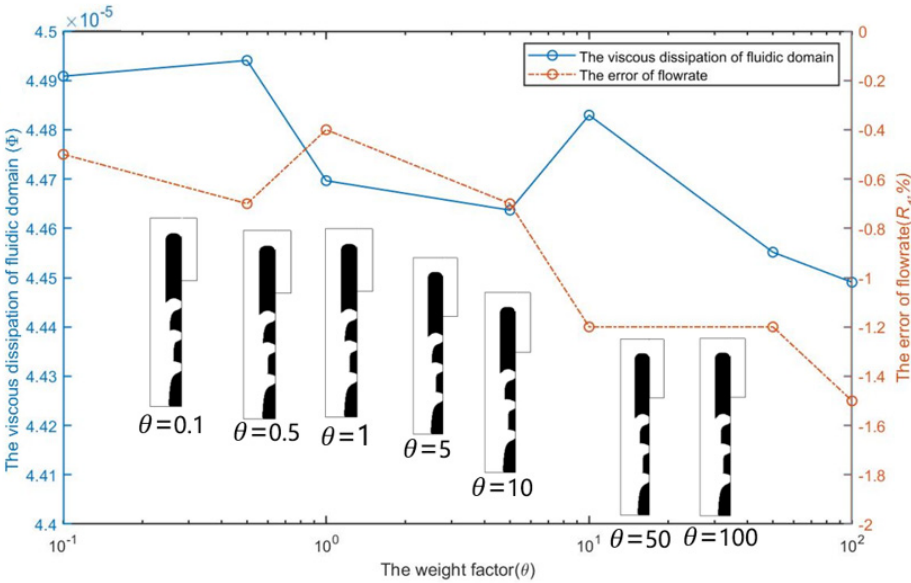
Figure 11. The optimization results and the effect of the weight coefficient θ on the error R 1 of flowrates and the viscous dissipation Φ of fluidic domain.